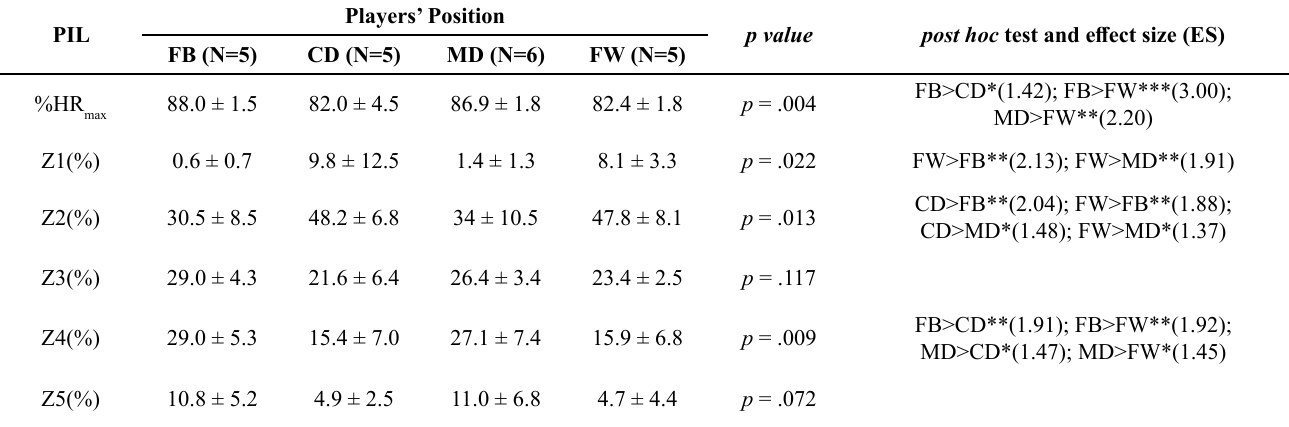
Table 1. Player internal load expressed as a percentage of maximal heart rate and time spent in five zones from each playing position during official match-play in youth soccer players. Players’ Position PIL FB (N=5) CD (N=5) MD (N=6) FW (N=5) %HR 82.0 ± 4.5 86.9 ± 1.8 82.4 ± 1.8 p = .004 max